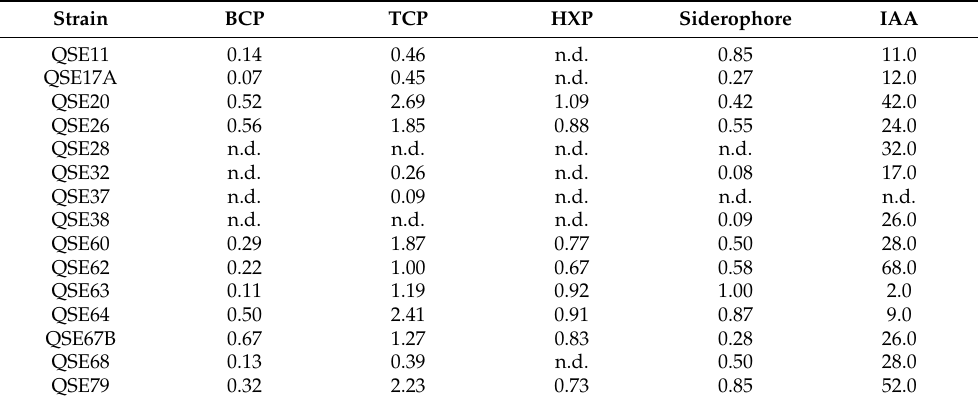
Table 2. Summary of PGP mechanisms detected in each selected strain.